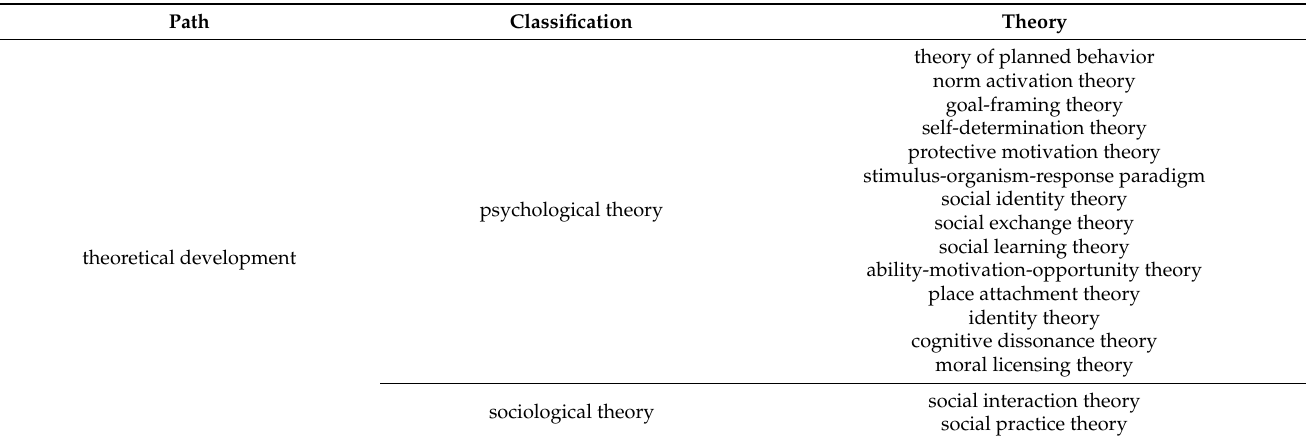
Figure 3. Theoretical progress of pro-environmental behavior. Table 3. Summary of theories.